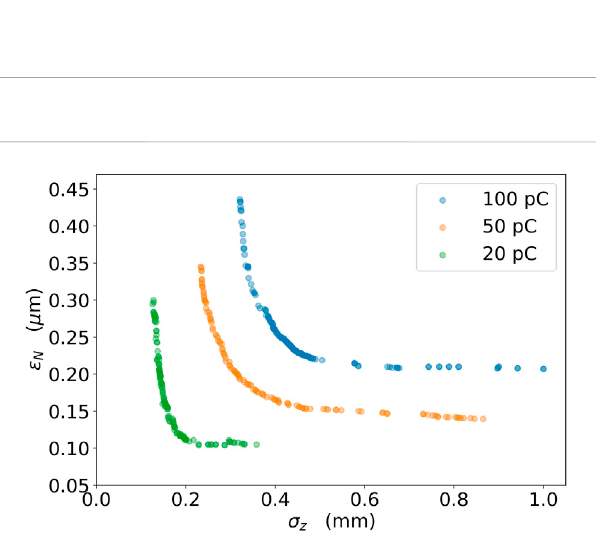
FIGURE 2 Paretofrontsoftransverseemittance ϵ nx andrmsbunchlength σ z for individual con fi gurations with different beam